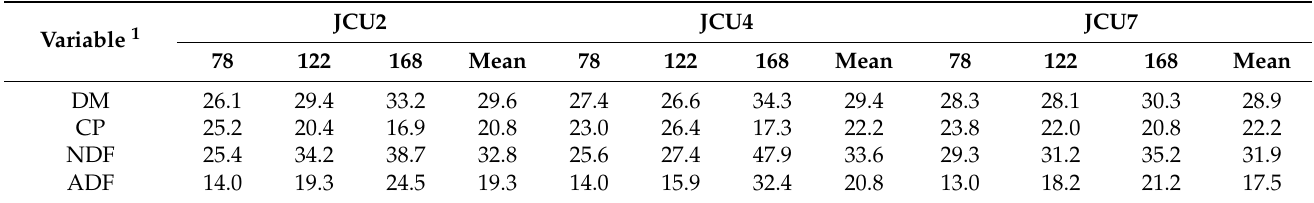
Table 3. Dry matter (%) and chemical composition (%DM) of desmanthus forage harvested 78, 122 and 168 days after